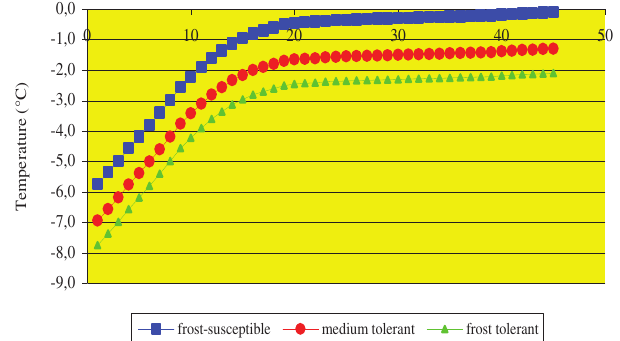
Figure 1 – The physiological LT50 function applied to apricot and peach varieties of different degrees of susceptibility for a period between April 1 and May